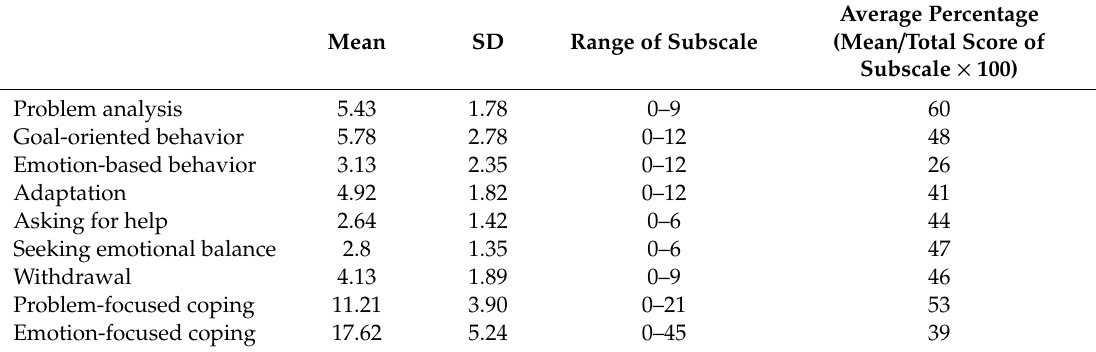
Table 3. Frequencies of coping strategies (measured with the Shortened (Hungarian) version of the Ways of Coping Questionnaire (WOC)) of Hungarian adults ( n = 431) during coronavirus lockdown.